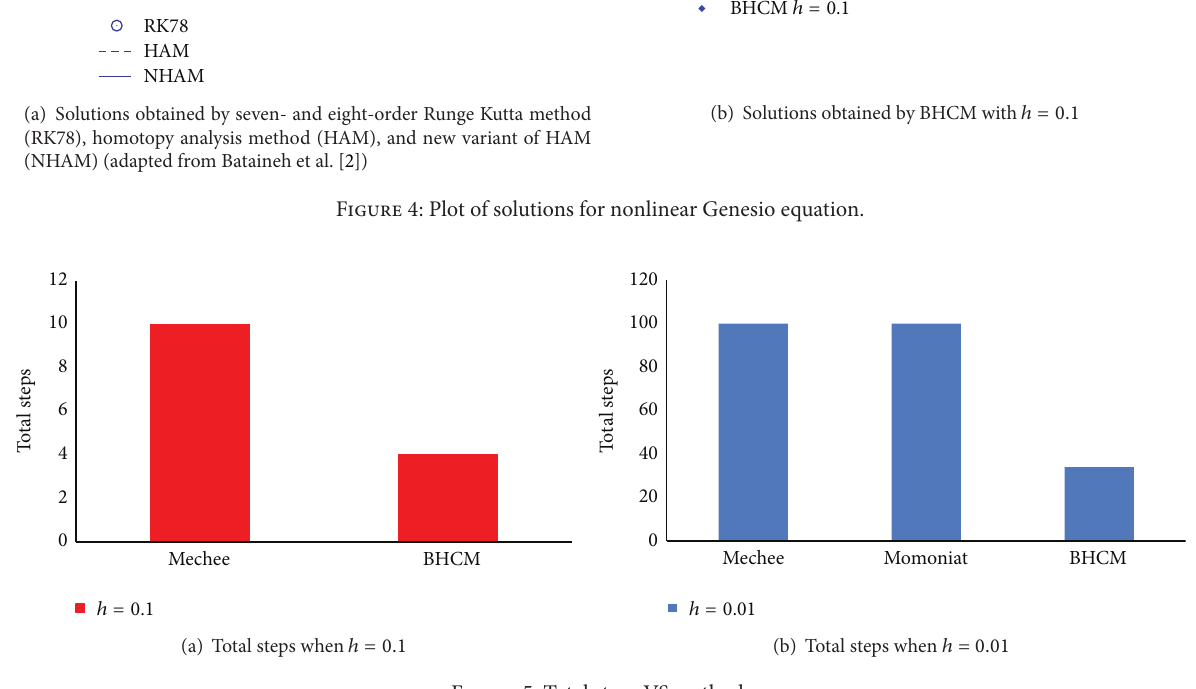
Figure 5: Total steps VS